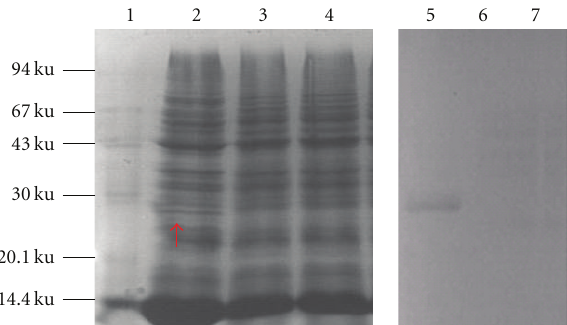
Figure 2: SDS-PAGE and western blot analysis. Total cell lysates were analyzed by SDS-PAGE and western blot. Coomassie blue gel staining shows the expression of a 27KD protein in pNZ8112-VP4/NZ9000 induced by nisin (lane 2, as arrow indi- cates the VP4 protein), and no corresponding protein in non- nisin induced pNZ8112-VP4/NZ9000 (lane 3) and nisin-induced pNZ8112/NZ9000 (lane 4) can be seen. Similar results were observed by western blot. Nisin-induced pNZ8112-VP4/NZ9000 (lane 5), non-nisin-induced pNZ8112-VP4/NZ9000 (lane 6), and nisin-induced pNZ8112/NZ9000 (lane 7), lane 1, Protein Molecular